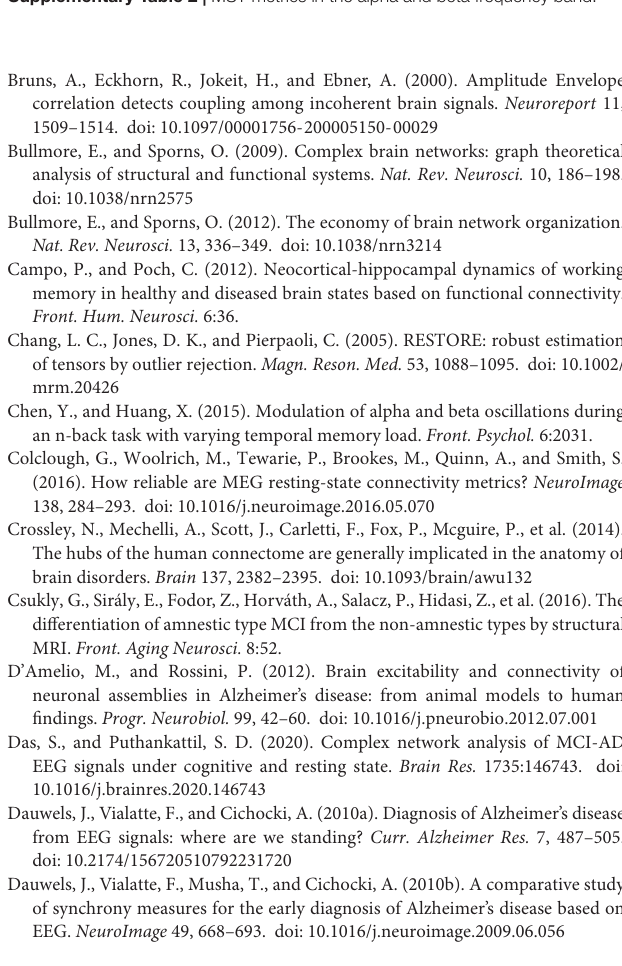
Supplementary Table 1 | Correlations between the temporal lobe structures and mean functional connectivity stratified by diagnosis. Supplementary Table 2 | MST metrics in the alpha and beta frequency